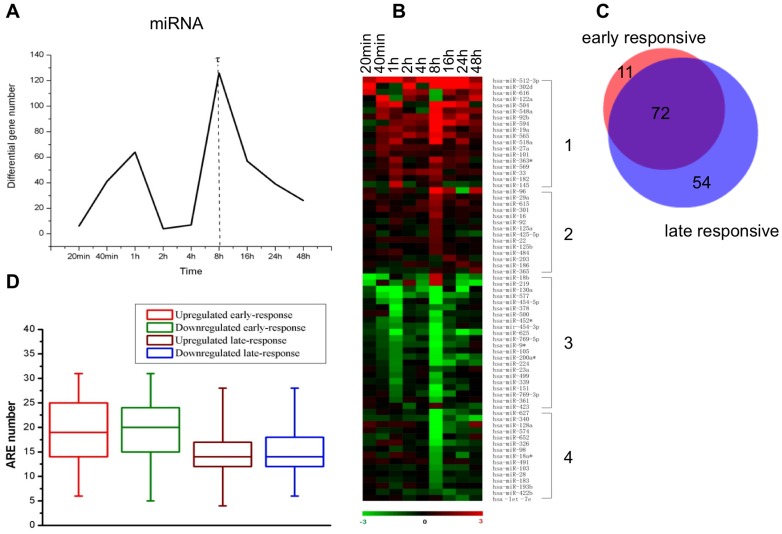
Time discriminator for distinguishing early and late response stages.
Figure 2A. Time course profile of differentially expressed miRNA number. The dashed line refers to time discriminator  for distinguishing early and late response stages. Figure 2B. Expression profile of miRNAs’ early- and late-response to DHT stimuli. Differential expression relative to 0 h is represented by .  separates miRNA response into early and late stages. miRNAs are clustered into 4 groups: early upregulated (1), late upregulated (2), early downregulated (3) and late downregulated (4). Figure 2C. Venn diagram for number distribution of early responsive miRNAs and late responsive miRNAs. The red part denotes the androgen-resonsive miRNAs with response happened solely at the early stage, the blue part denotes miRNAs with response solely at the late stage, and the purple part denotes miRNAs with response both at the early and late stages. Figure 2D. Predicted ARE enrichment in early and late responsive miRNA genes. AREs are in the ±10 kb sequences flanking 5′-start site of pre-miRNAs.